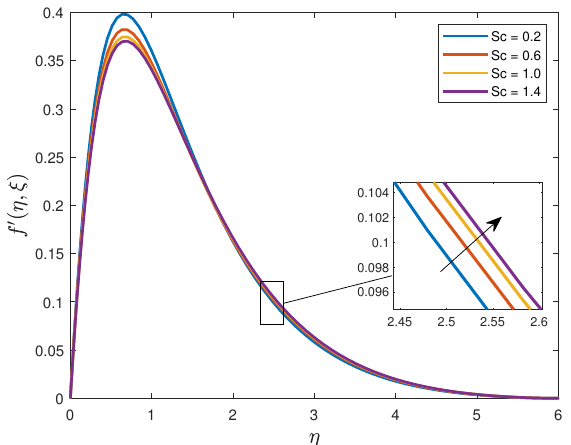
Figure 10. The influence of Sc on fluid velocity.